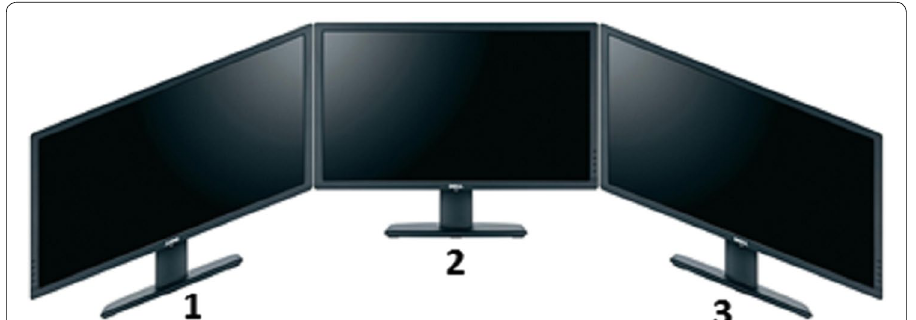
Fig. 9 Naming convention of each workstation’s three monitors, labeled as 1, 2, 3 from left to